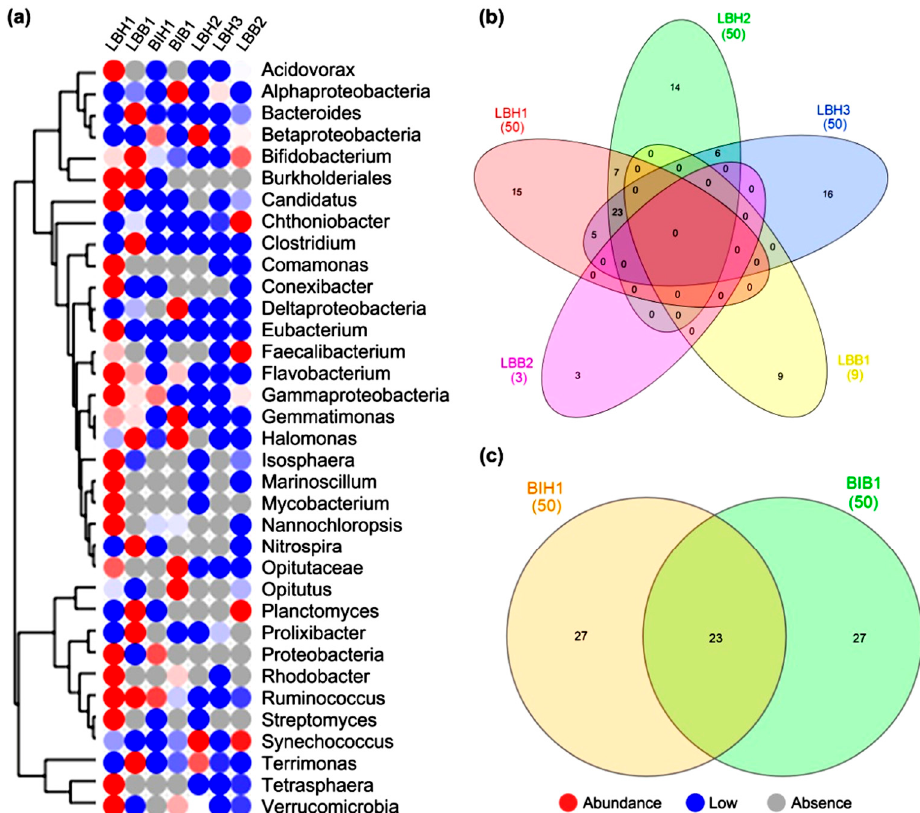
Figure 4. Top hits operational taxonomic units comparison based on genus-level for selected healthy and bleached sponges. ( a ) The heat map represents the abundances of annotations of taxonomic richness and evenness on a log scale. ( b , c ) The Venn diagram represents the common and unique genus found in the samples.